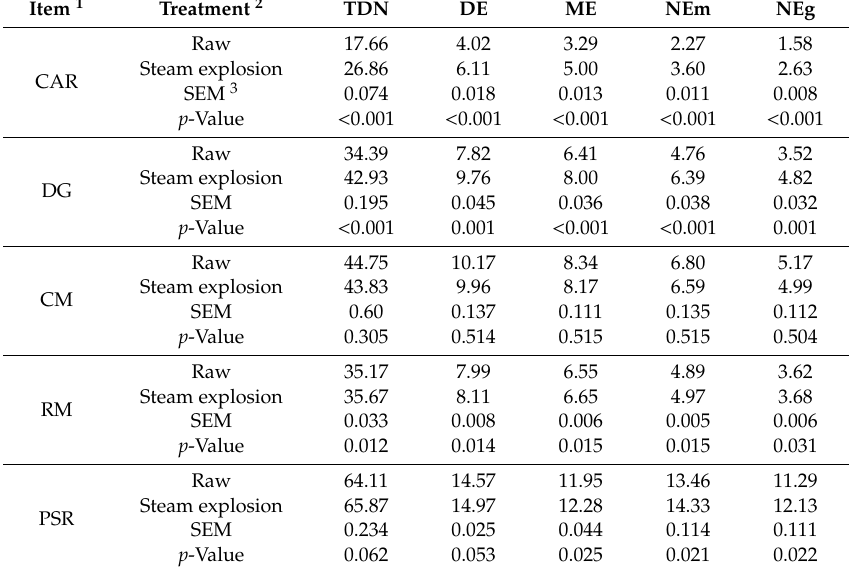
Table 2. E ff ect of steam explosion treatment on the energy values of five byproduct feedstu ff s (DM basis, expressed as